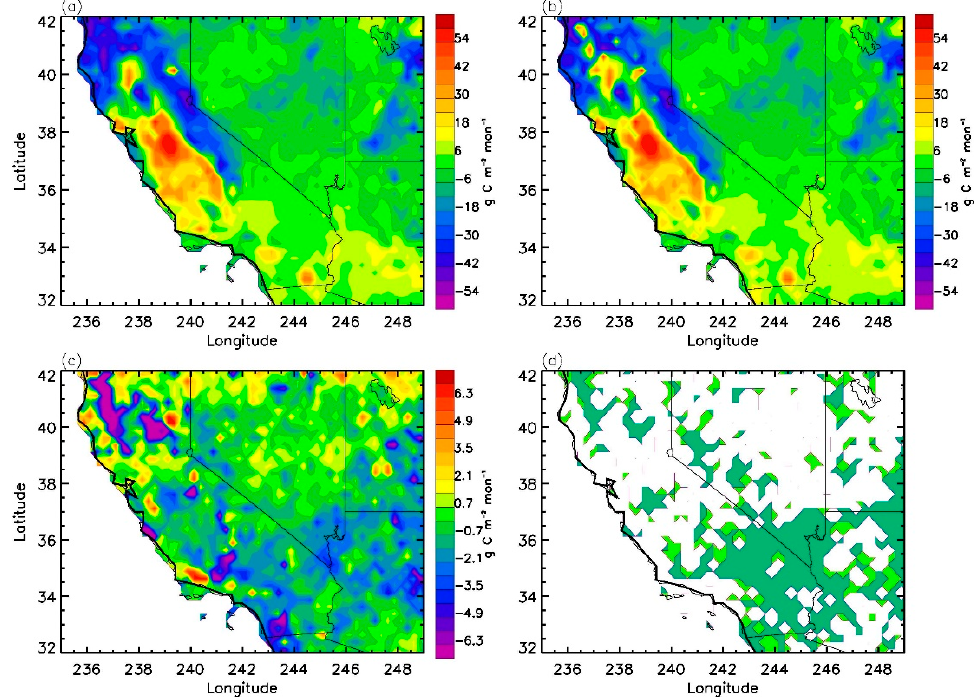
Figure 4. ( a ) The mean value of Net Ecosystem CO 2 Exchange (NEE), from the CASA model, in dry years (JJAS of 2003, 2007, and 2010); ( b ) the mean value of NEE in wet years (JJAS of 2006, 2008, 2011, and 2012); ( c ) NEE differences between the dry and wet years; and ( d ) NEE differences within 5% significance level and 1% significance level are highlighted in light green and dark green. Units for NEE are g C m − 2 mon − 1 in ( a – c ).